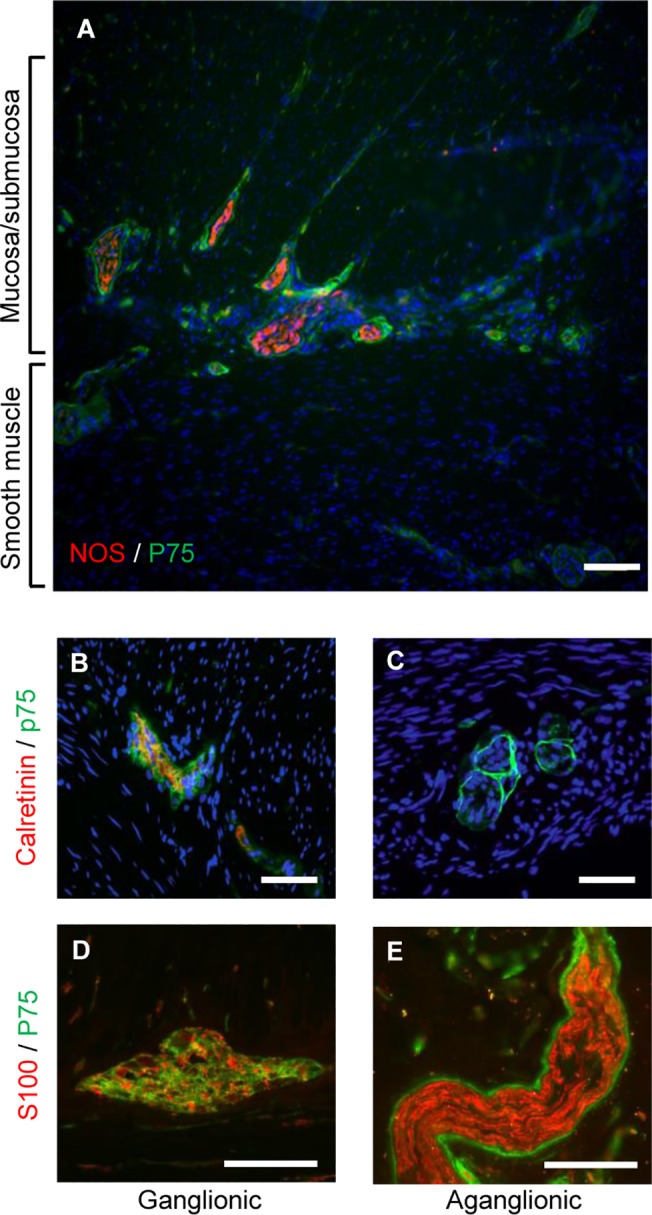
Expression of neural markers in colonic biopsies from Hirschsprung patients.A) Full thickness frozen section of aganglionic Hirschsprung bowel showing thickened nerve trunks immunolabeled for the neural crest cell marker p75 (green) and neuronal NOS (red). Note abundance of nerve trunks and fibers in the submucosal region, together with fewer thicker nerve trunks in running through the smooth muscle (C, E). B) Immunolabeling of frozen sections for calretinin expression (red) confirmed presence of ENS in ganglionic gut, and its absence in distal aganglionic gut (C). Antibodies to p75 also stained myenteric ganglia (green) in the frozen sections (B, D). The thickened nerve trunks of aganglionic gut displayed p75 immunoreactivity with very strong immunofluorescence in the perineurium and lower levels of immunoreactivity in the endoneurium (C, E). The glial cell marker S100 was also expressed (red) in ganglia (E) and endoneurium of the thickened nerve trunks of aganglionic gut (E). In contrast to p75 staining, there was no S100 immunoreactivity in the perineurium of the thickened nerve trunks (E). All sections are counterstained with DAPI and are typical of the 12 short segment Hirschprung’s tissues examined. Scale bars: A = 120μm; B—E = 100 μm.